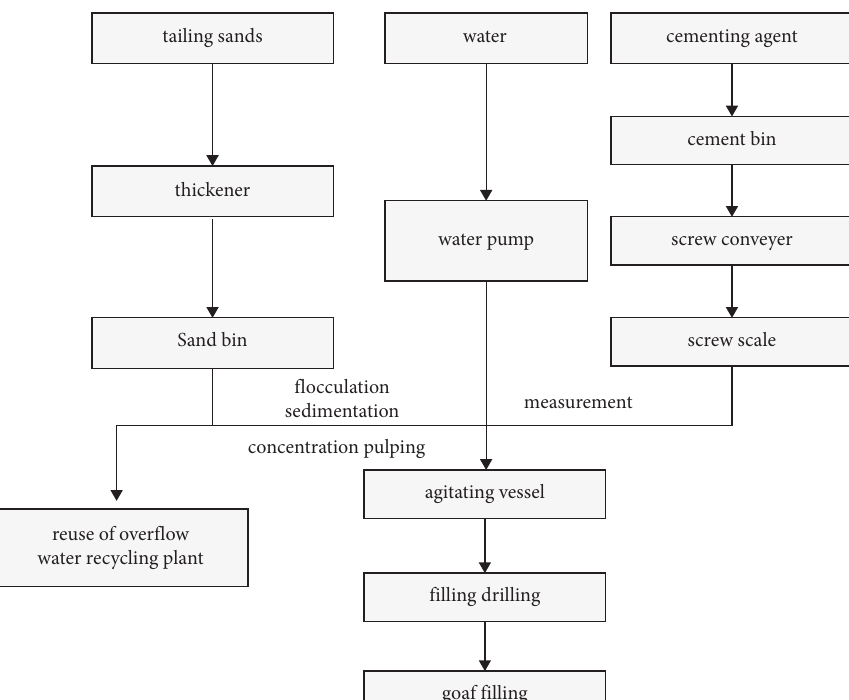
Figure 7: Flowchart of filling process after technical